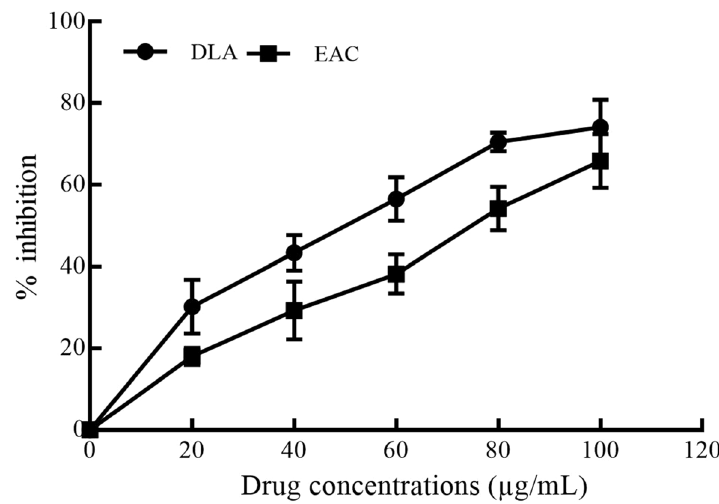
Fig. 1 Short-term cytotoxicity of K. pinnatum on murine tumour cells using trypan blue dye exclusion method